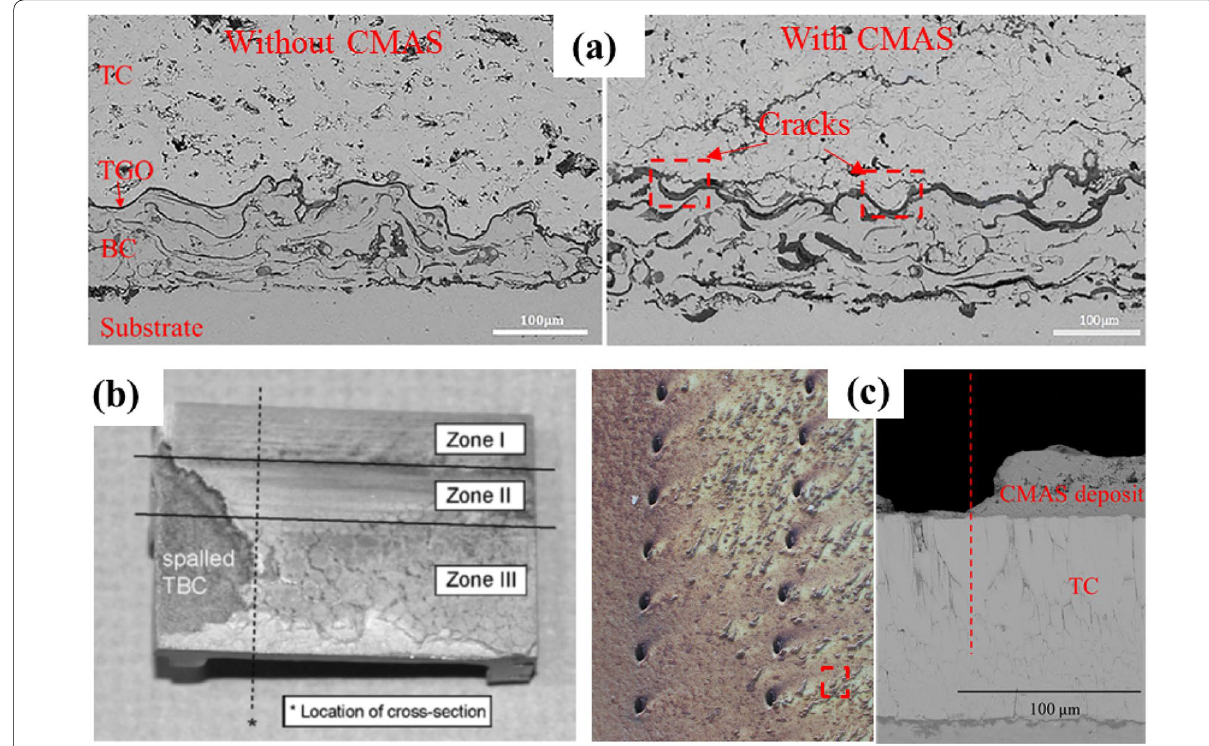
Figure 1 ( a ) Cross-section of APS TBCs without/with CMAS penetration, ( b ) Plan-view optical image showing turbine shroud segment with peeling of TBCs, ( c ) Cross-section image of non-uniform CMAS deposit distribution around partition